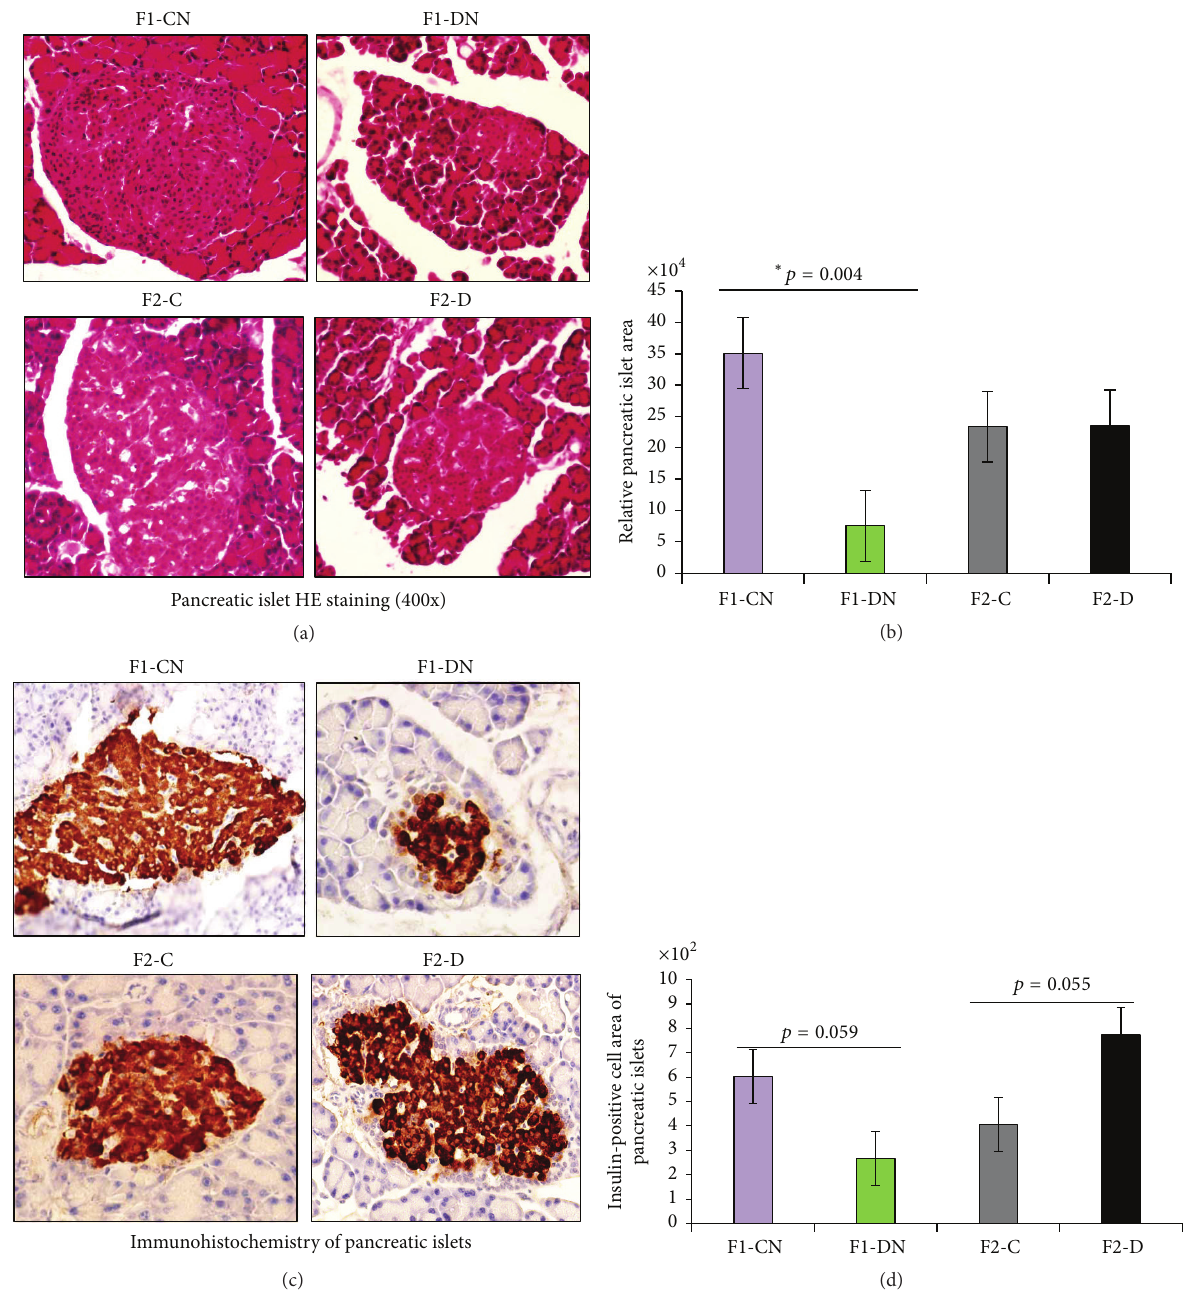
Figure 5: Histology and immunohistochemistry of pancreatic islets. (a) HE staining images (400x) of pancreatic islets obtained from F1 and F2 offspring. (b) The area and diameters of pancreatic islets were measured using Image-Pro Plus 6.0, Media Cybernetics. Ten different fields were analyzed for each rat, with a total of six rats per group. (c) Immunohistochemistry of pancreatic islets. (d) Insulin-positive cell area of pancreatic islets was measured using Image-Pro Plus 6.0. Ten different fields were analyzed for each rat; totally six rats in each group were analyzed. Results are presented as means ± SEM, 𝑁 = 6 per group; ∗ 𝑝 < 0.05 versus F1-CN.